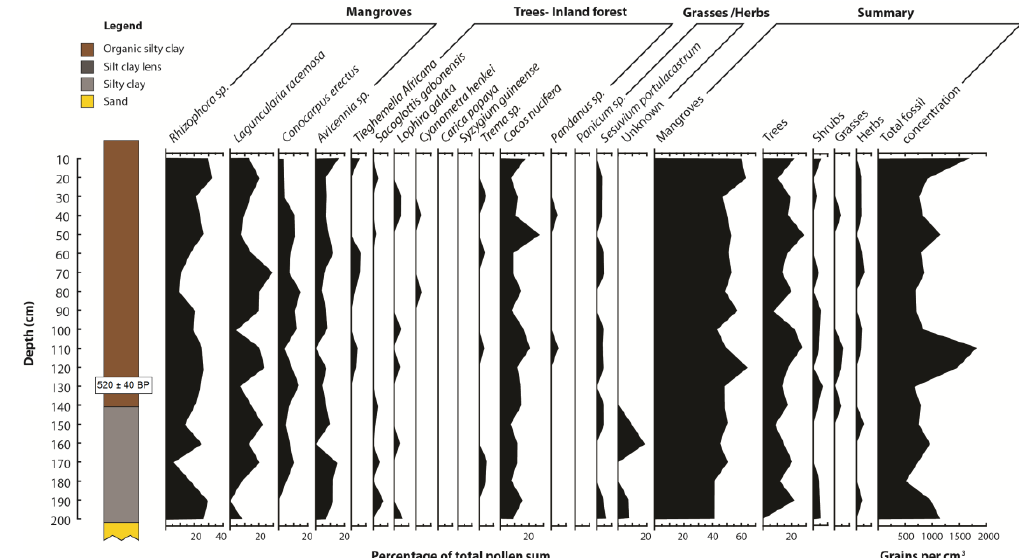
Figure 7. Stratigraphy and pollen results of the Moukouke Island core. Pollen is shown by percentage of pollen presence of the total pollen sum, and total fossil pollen